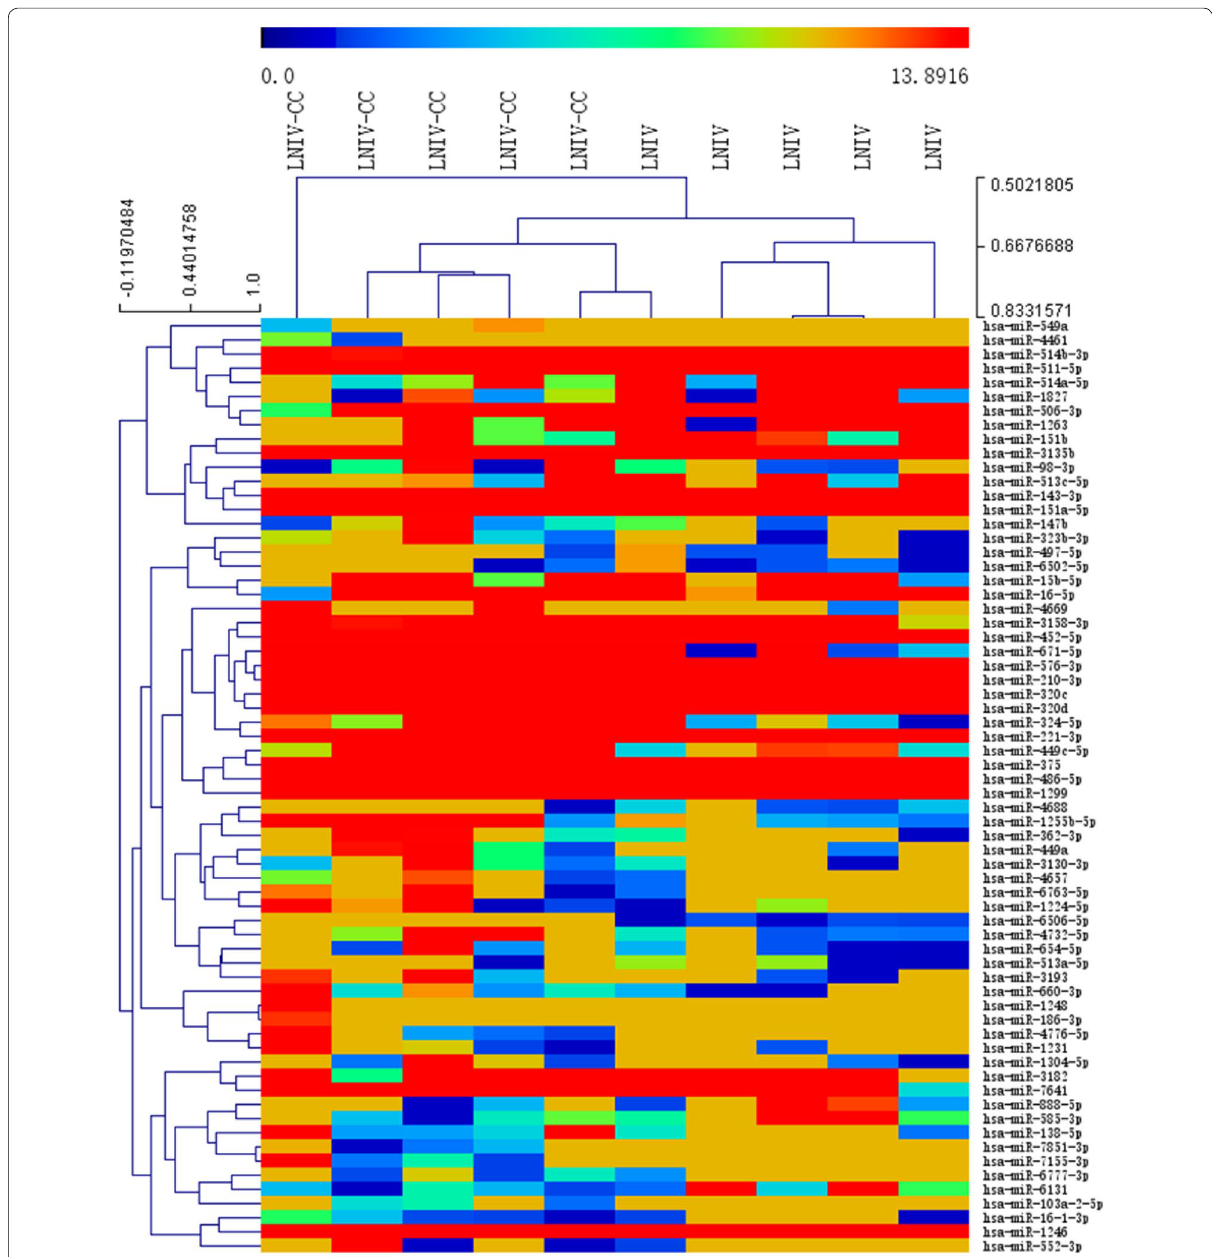
Fig. 4 Heatmaps of differentially expressed miRNAs ( p < 0.05) between LNIV-CC and LNIV (active)